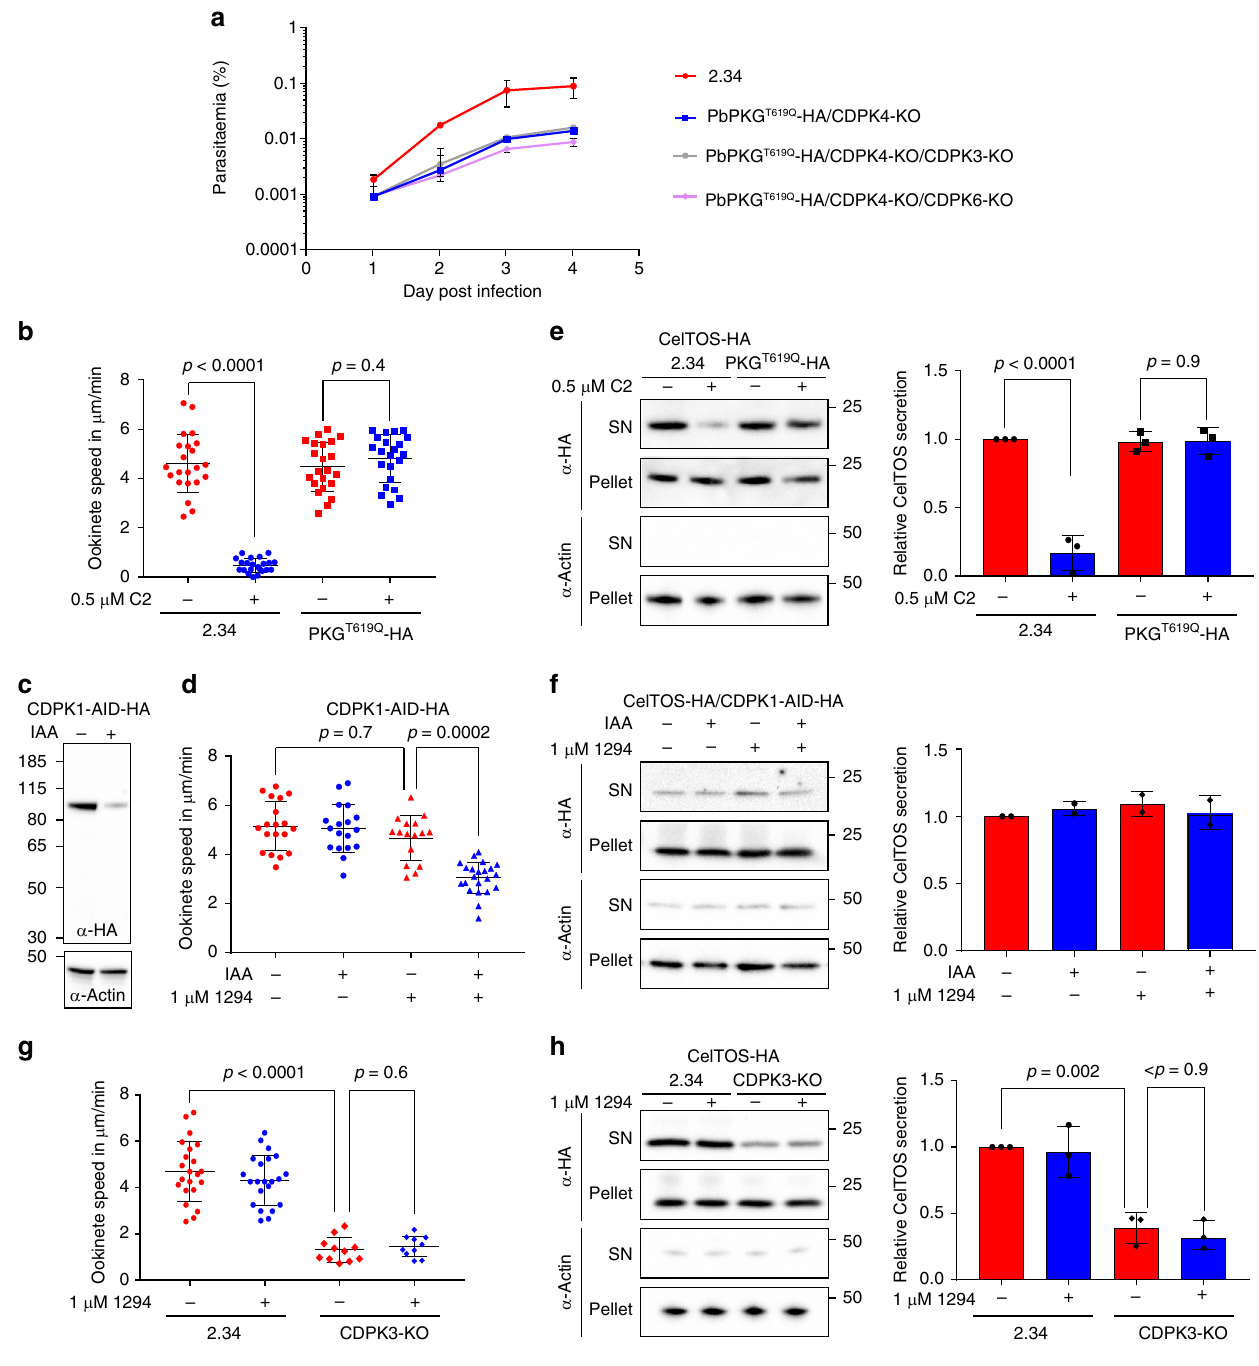
(Fig. 5c and ref. 39 ). PbCDPK1-AID-HA ookinetes show